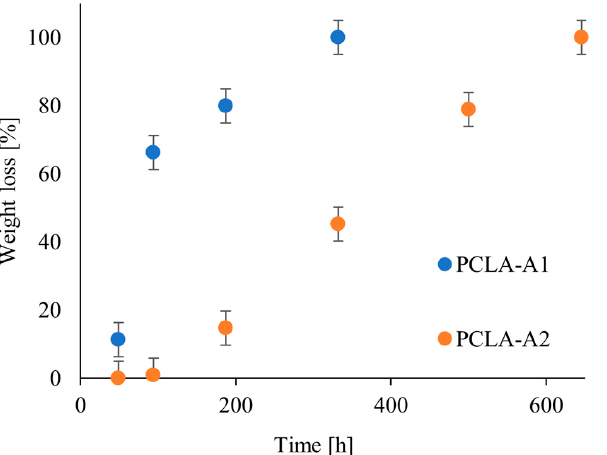
Figure 11. Hydrolytic degradation profiles of the PCLA-A1 and PCLA-A2 hydrogels at 25 wt.%.